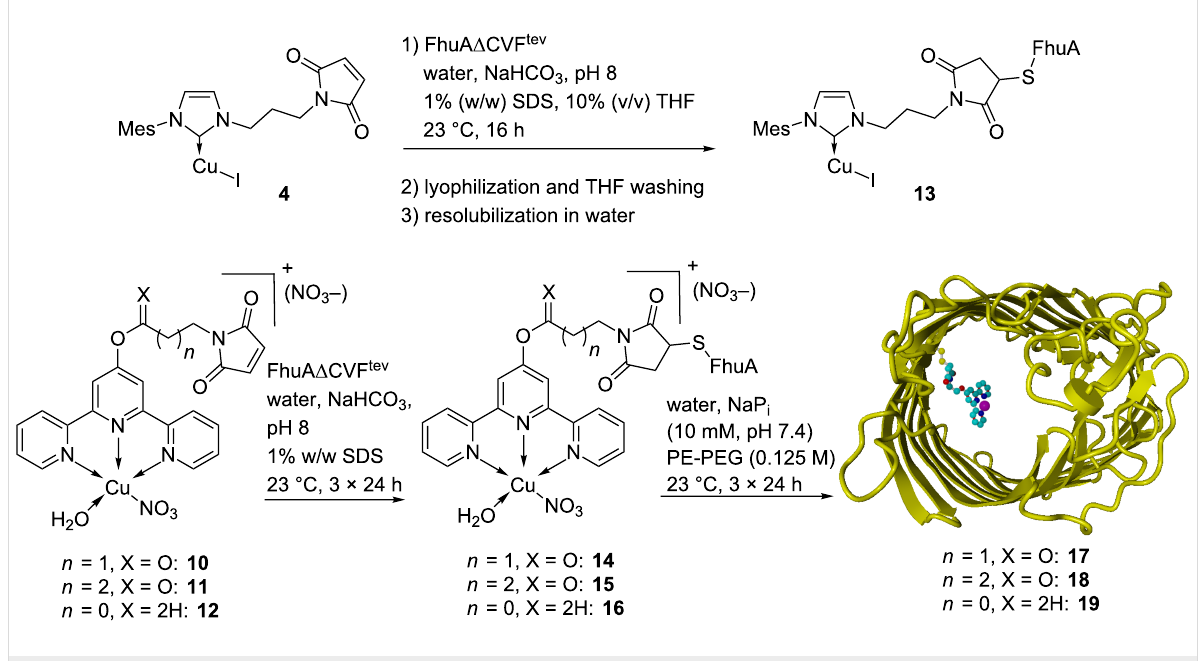
Scheme 3: Anchoring and refolding of the biohybrid copper complexes.